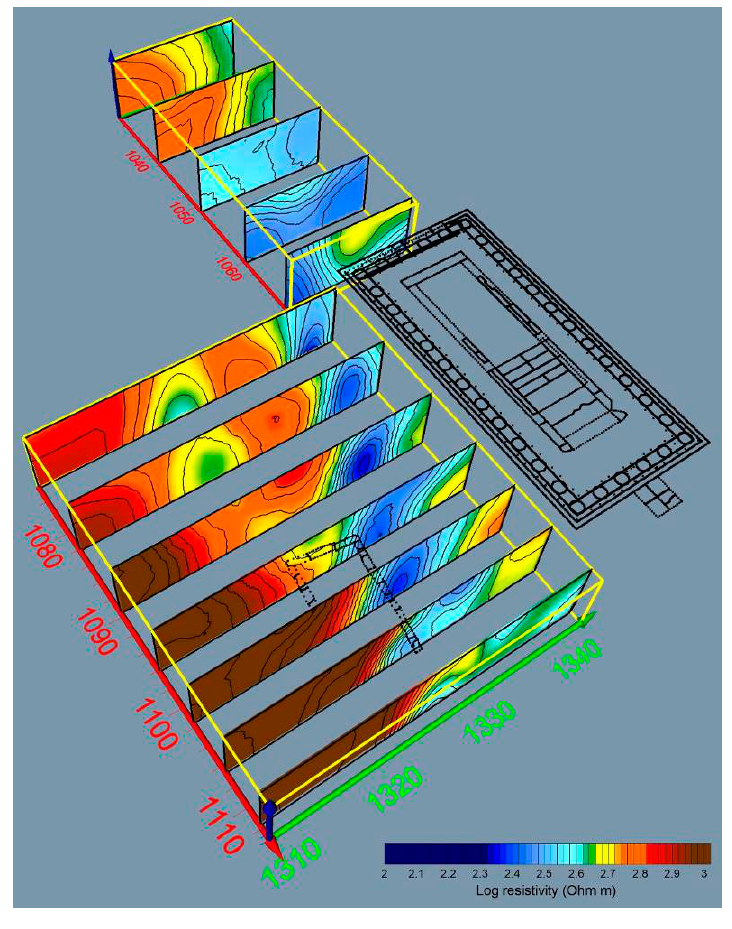
Figure 12. Sequence of vertical tomography sections oriented in the N–S direction.